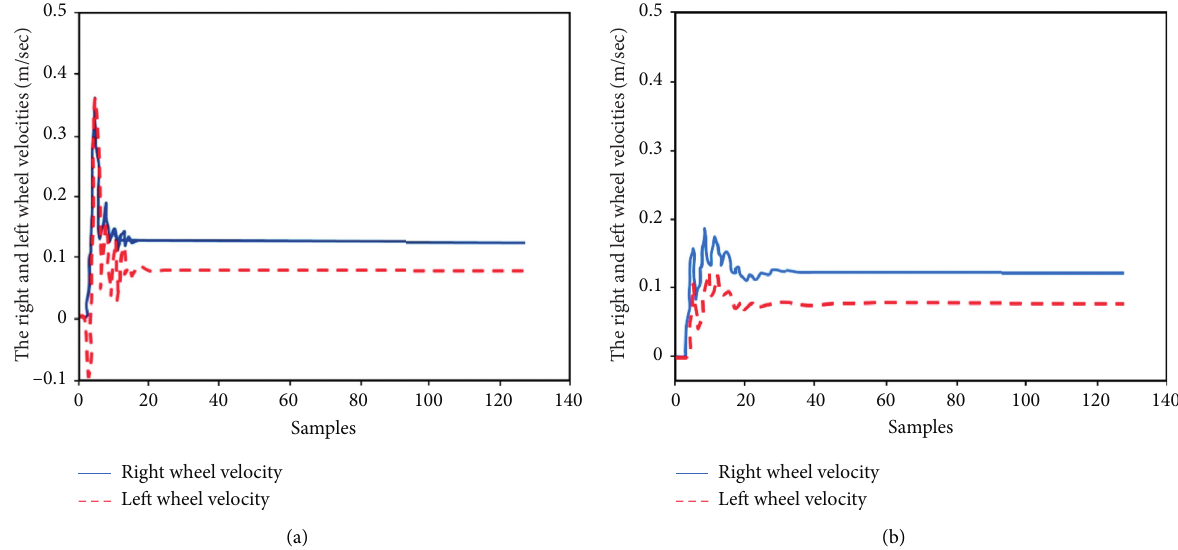
Figure 7: The left and right wheels’ velocity of DDMR for circular trajectory. (a) Wheels’ velocity with NNPID and (b) wheels’ velocity with